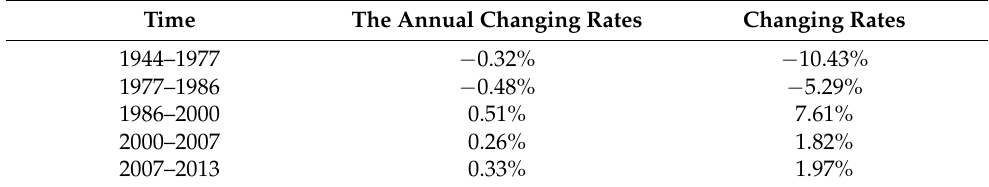
Table 1. The annual changing rates of forest landscape in different historical periods. (We constructed this table using WPS office (https://platform.wps.cn/) (accessed on 19 December